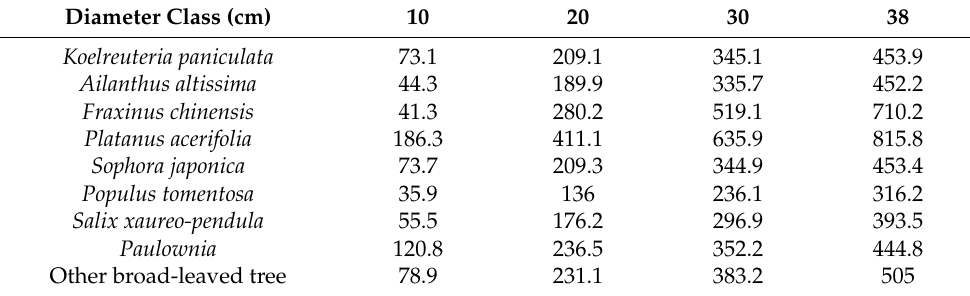
Table 6. Leaf area of individual broad-leaved trees in different diameter classes (m 2 ).